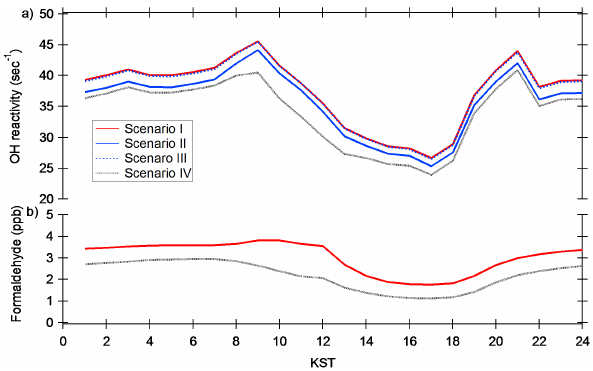
Figure 6. The temporal distributions of UWCM-calculated OH re- activity (a) and formaldehyde (b) from different model calculation